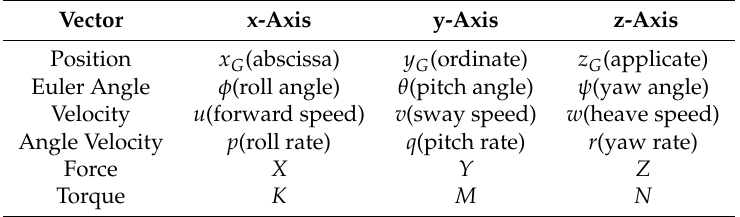
Table 1. Notions used for